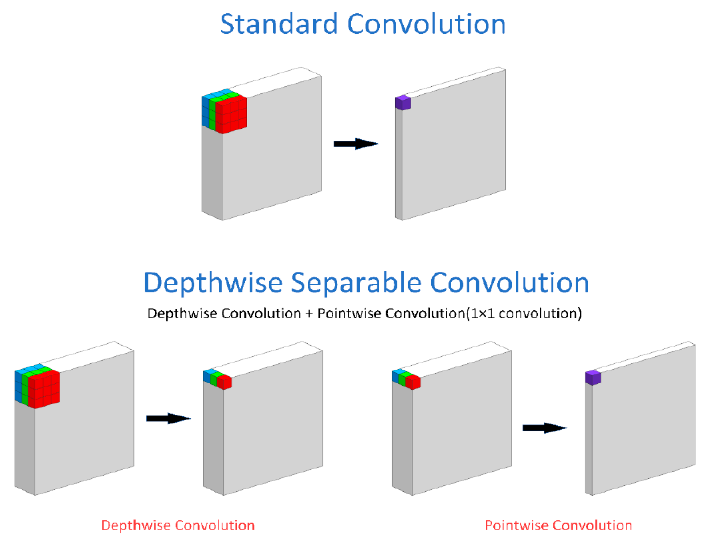
Figure 6. Standard convolution vs. depthwise separable convolution.